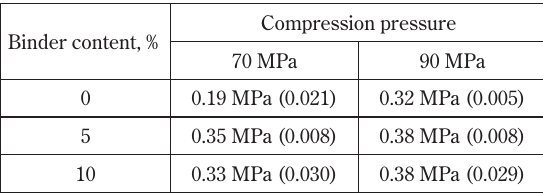
Table 3 Diametral strength of tablets made from dry powder formulations at 70 and 90 MPa com- pression pressures and different binder con-